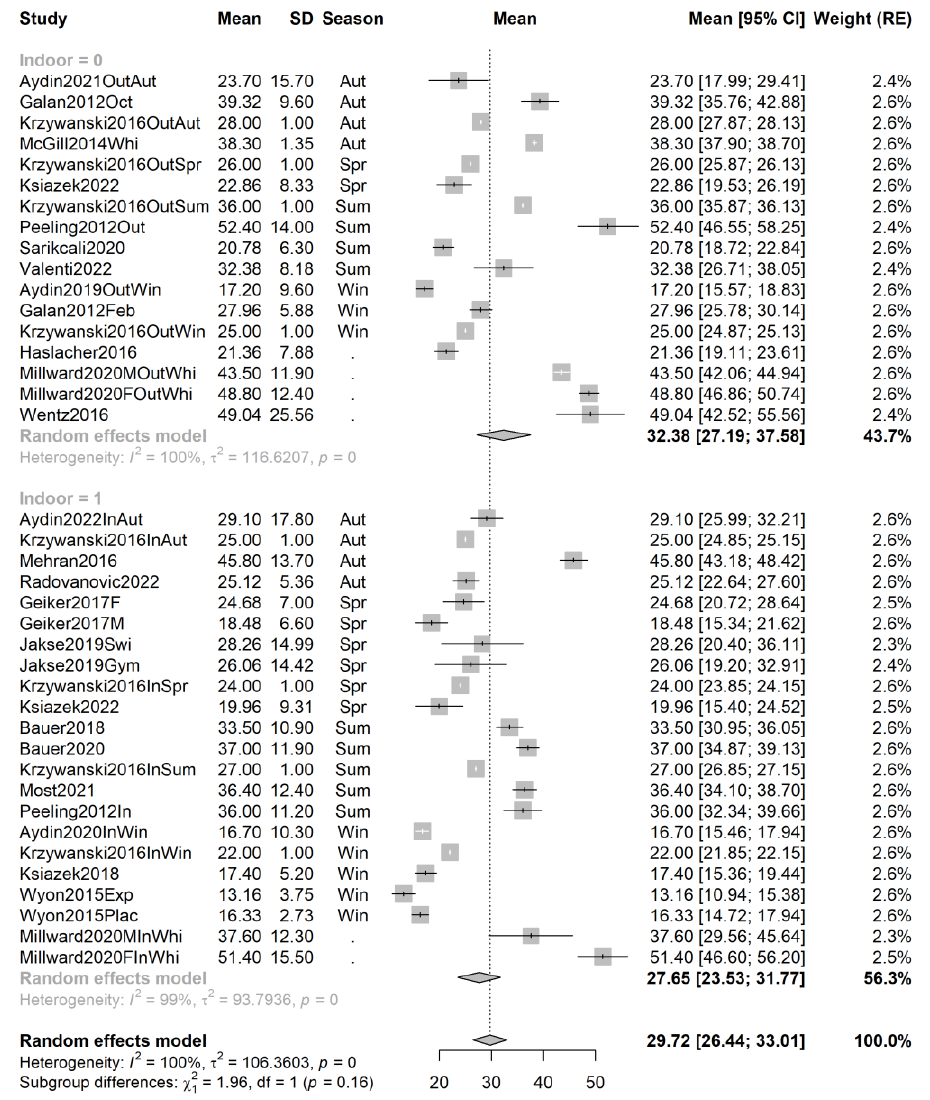
Figure 5. Forest plot of all studies performed on Caucasian athletes sorted by season. Studies [40– 42,44,46,49–55,57,60,63,64,66,68,71,72].